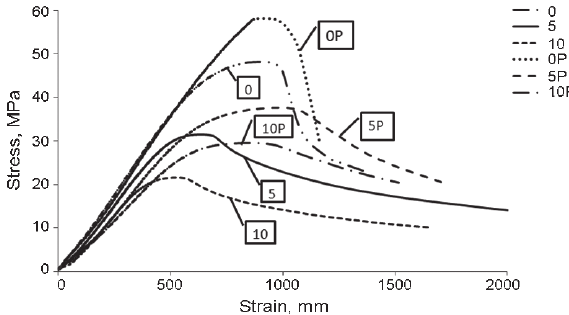
Fig. 8. typical compressive stress–strain response by ecW